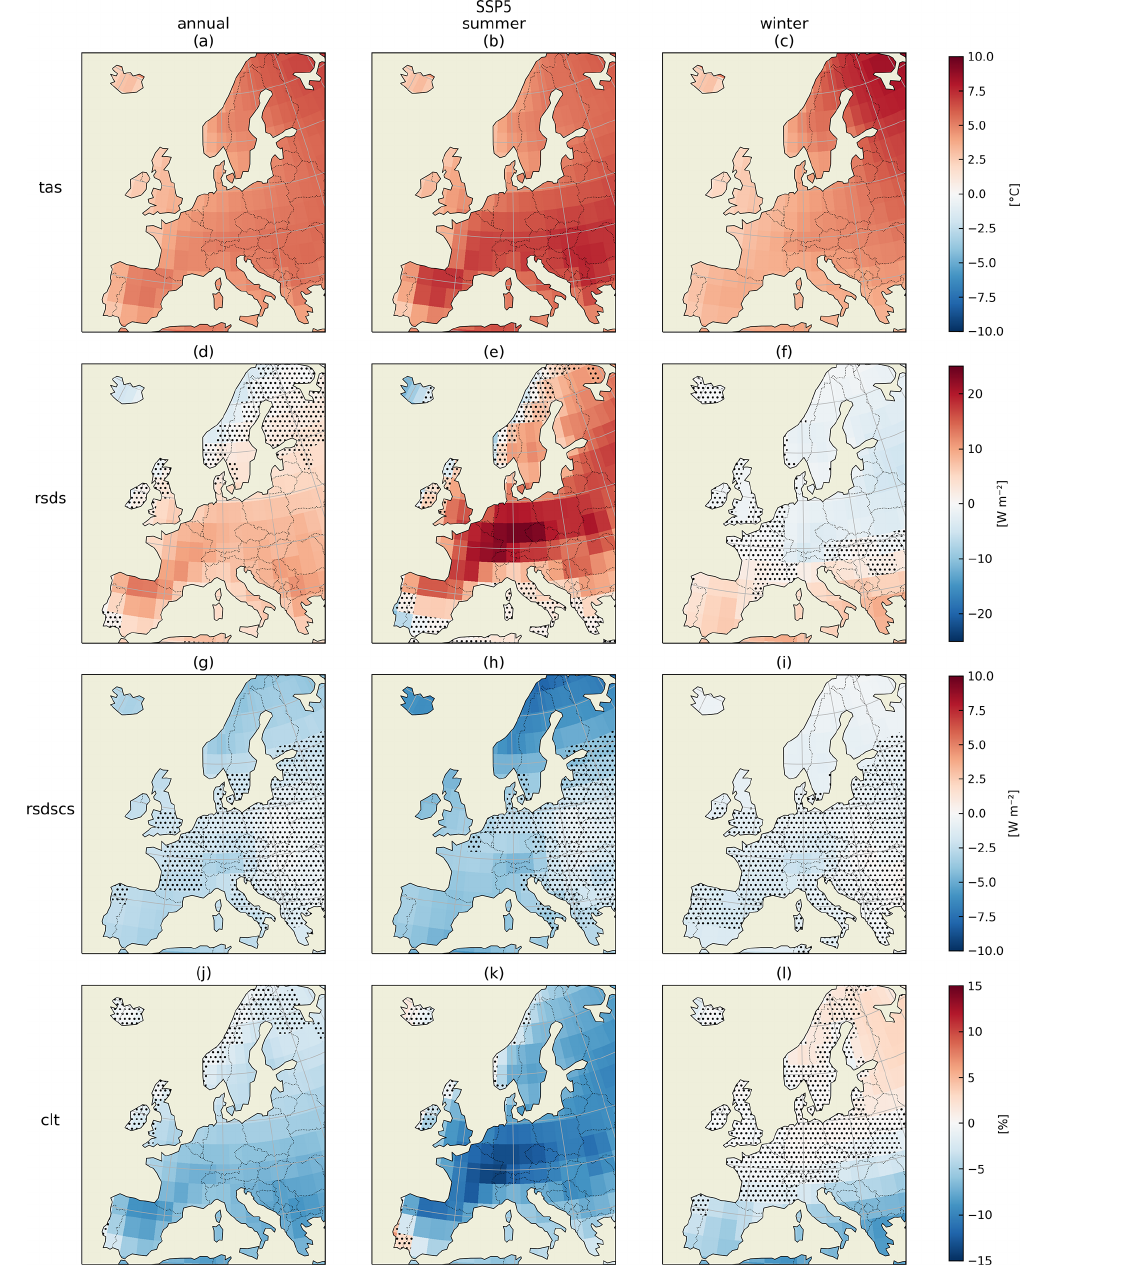
Figure 2. Change in climate variables relevant for PV production in SSP5-8.5. The figure is structured in the same way as Fig.